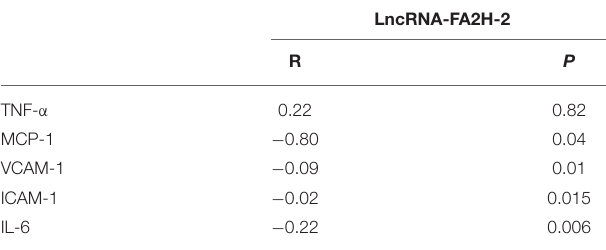
TABLE 8 | Correlation analysis of LncRNA-FA2H-2 and TNF- α , MCP-1, VCAM-1, ICAM-1,